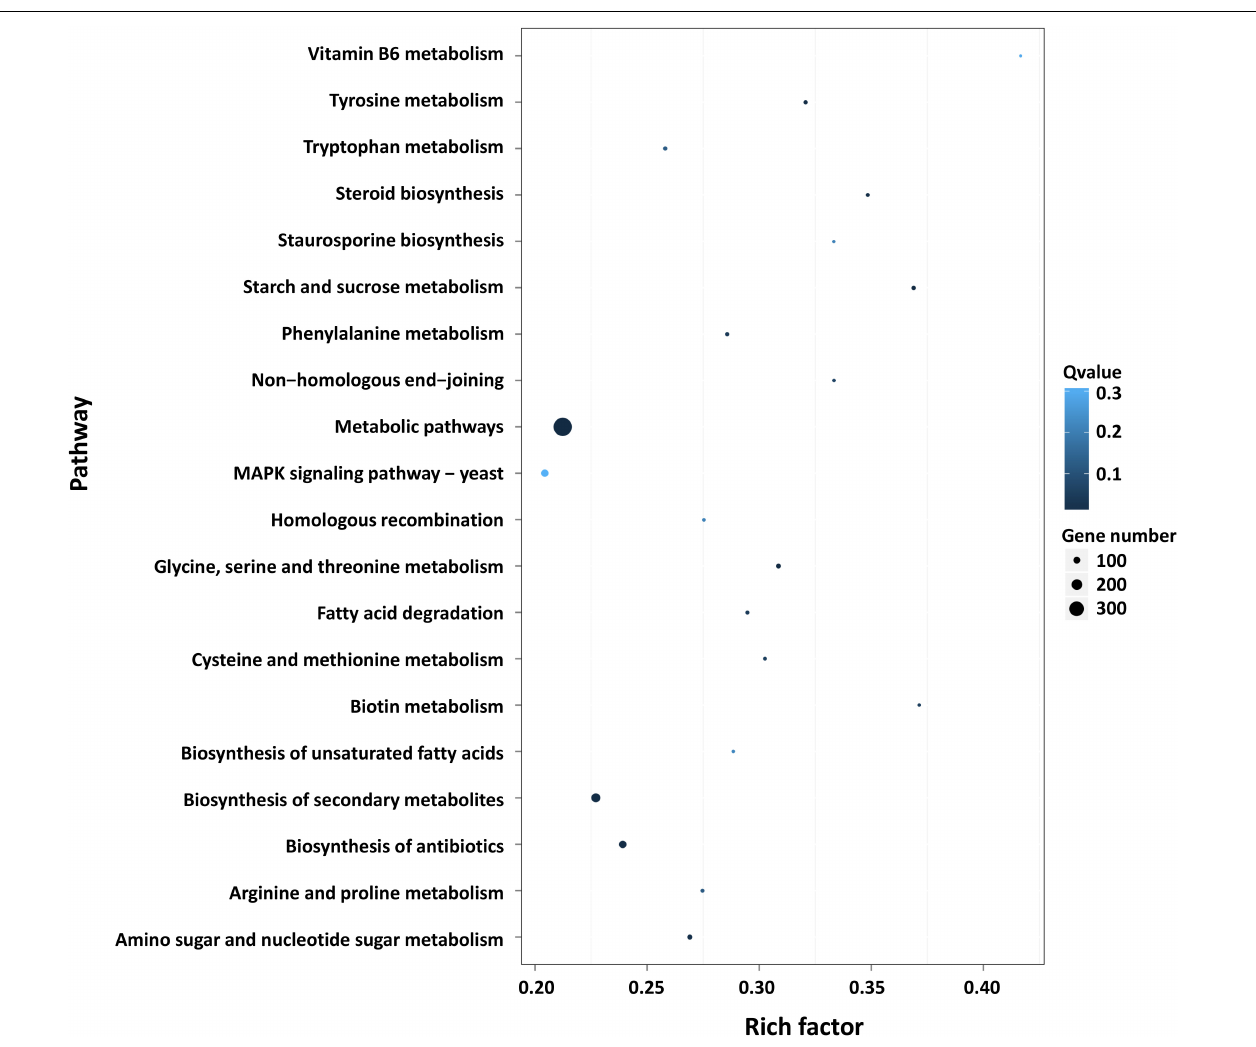
FIGURE 3 | Pathway functional enrichment of DEGs. X axis represents the enrichment factor. Y axis represents the pathway name. Coloring indicates the q -value (high: white; low: blue), and the lower q -value indicates the more significant enriched. The point size indicates the number of DEGs (more: big; less: small).